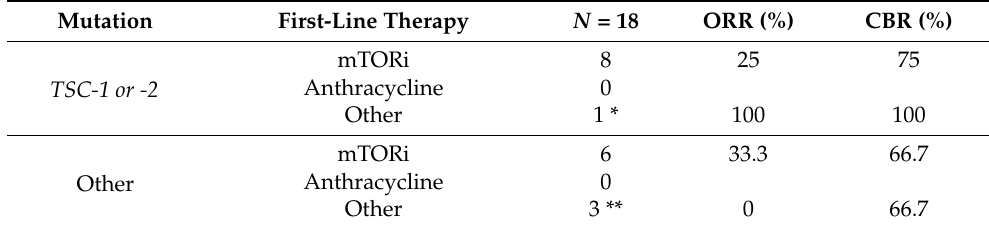
Table 2. Overall response rate and clinical benefit